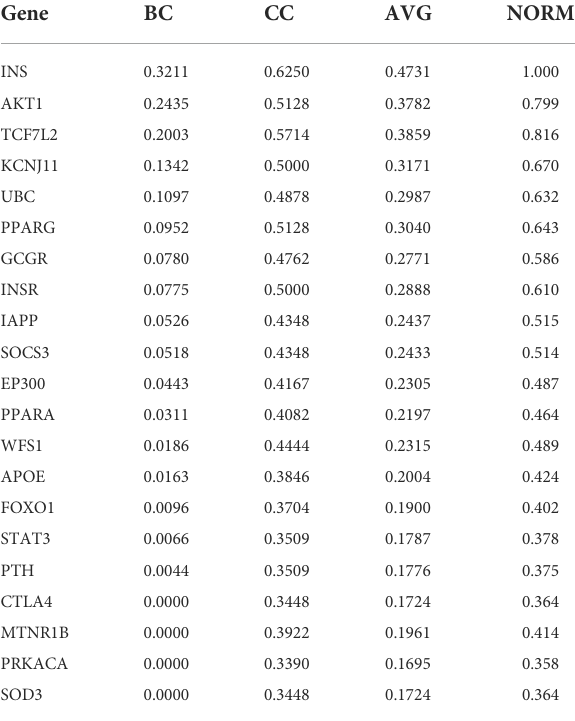
TABLE 2 Protein weight normalization